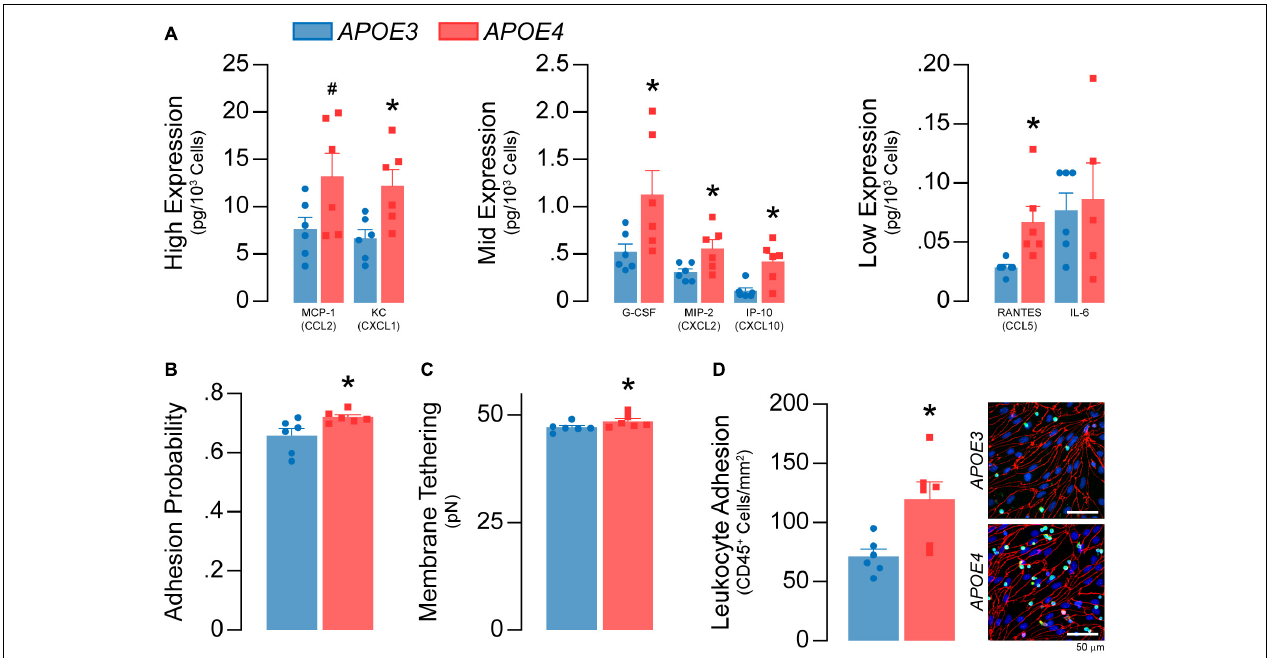
FIGURE 8 | APOE4 brain endothelial cells have a greater inflammatory phenotype under basal conditions. (A) The media of APOE4 brain endothelial cells has higher levels of MCP-1/CCL2, KC/CXCL1, G-CSF, MIP-2/CXCL2, IP-10/CXCL10, RANTES/CCL5 and IL-6 when assessed by multiplex ELISA. (B) Higher inflammation can lead to greater immune cell adhesion that involves selectin-mediated capture. Selectin-mediated binding can be evaluated via atomic force microscopy, using cantilevers coated/biofunctionalized with the selectin ligand sialylic-Lewis x (sLe x ). In this assay, the biofunctionalized cantilever tip touches and indents the cell, then retracts; binding of sLe x to selectins on the plasma membrane results in a rupture event when the cantilever is retracted (Askarova et al., 2013). Thus, two parameters are obtained; adhesion probability (i.e., whether a rupture occurs and, therefore, selectin binding) and selectin-mediated membrane tethering force (i.e., the force needed to rupture the tether). In APOE4 brain endothelial cells there is higher sLe x -mediated adhesion probability and (C) membrane tethering force (analyzed by paired t -test). Immune cell adhesion can be directly assessed using a leukocyte adhesion assay. In this assay, unstimulated leukocytes (white blood cells) isolated from the spleens of APOE3 -targeted replacement mice are spiked into the media of brain endothelial cell cultures. After 60 minutes, loosely adherent and unbound cells are removed and the remaining, firmly adherent cells are quantified by immunocytochemistry (CD45) (Lutz et al., 2017). (D) Consistent with AFM data, there are more CD45 + leukocytes adhered to APOE4 brain endothelial cells. Data is expressed as mean ± S.E.M. * p < 0.05 by Student’s t -test with n =